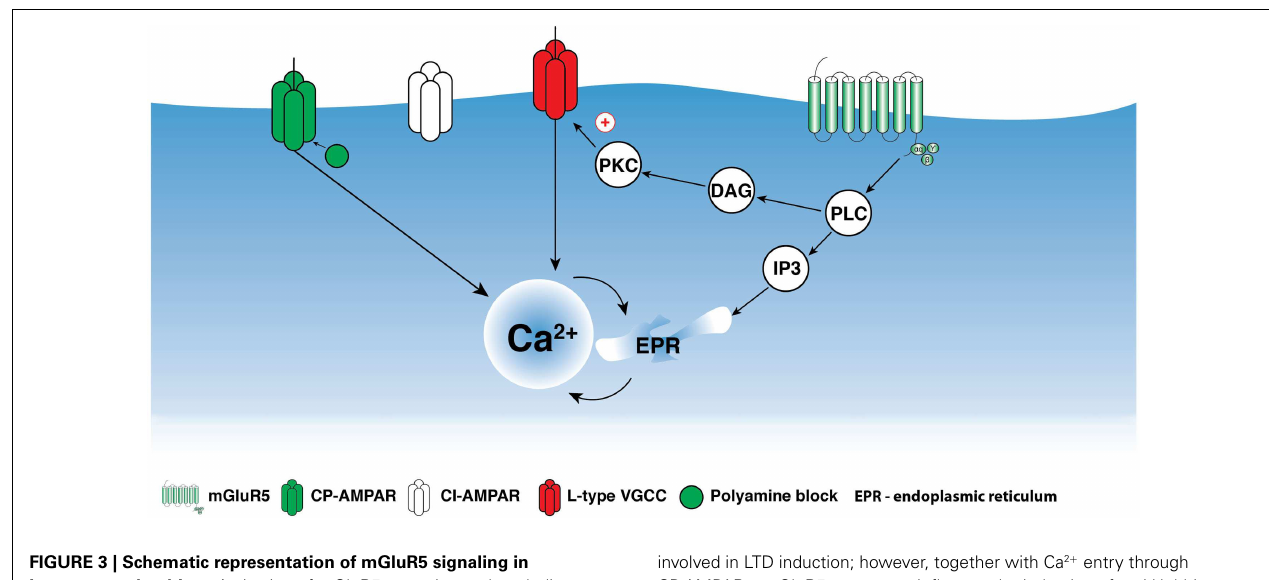
FIGURE 3 | Schematic representation of mGluR5 signaling in interneuron dendrites. Activation of mGluR5 may trigger phospholipase C (PLC) activation producing inositol-1,4,5-triphosphate (IP 3 ) and Ca 2 + release from intracellular stores as well as diacylglycerol (DAG)/protein kinase C (PKC) activation. mGluR5-mediated Ca 2 + release alone can be